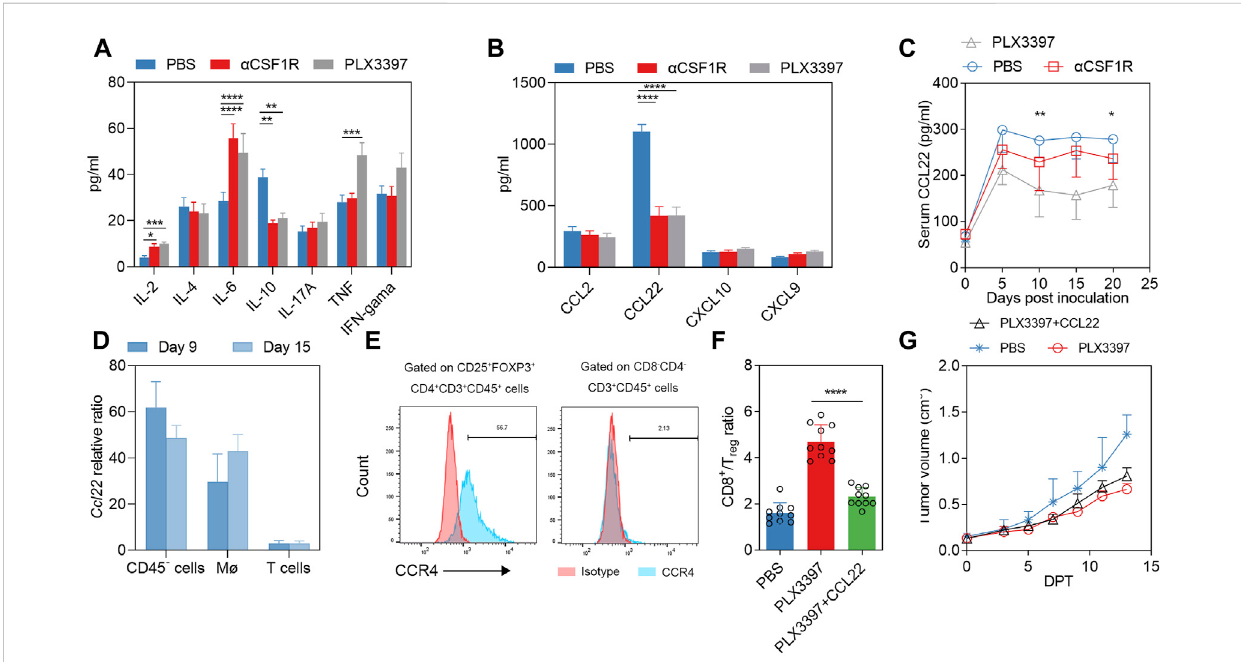
FIGURE 3 PLX3397 and α CSF1R reduce TAM-derivedCCL22that affect Tcell recruitment. (A) 15 daysafter treatment began,serum ofmice ineach group was collected and the CBA method was used to detect Th1/Th2/Th17-related in fl ammatory factors, n = 10. (B) 15 days after treatment began, serum chemokine levels of CCL2, CCL22, CXCL10 and CXCL9 were detected by ELISA kit, n = 10. (C) Serum levels of CCL22 at day 0,5,10,15 and 20 during the development of murine subcutaneous tumors, with treatment starting at day 7 after tumor inoculation, n = 10. (D) Macrophages, T cells and CD45 − cellswithinthetumoron9DPTand15DPTweresortedandtheoveralltranscriptionlevelsofthesecellswereanalyzed. (E) Representative fl owcytometry histogramofCCR4levelsinTregintumorofLLCsubcutaneoustumormodel. (F) CD8T/Tregratioat13DPTtreatedwithCCL22combinedwithPLX3397; And (G) tumor volume changes in during the treatment, n =